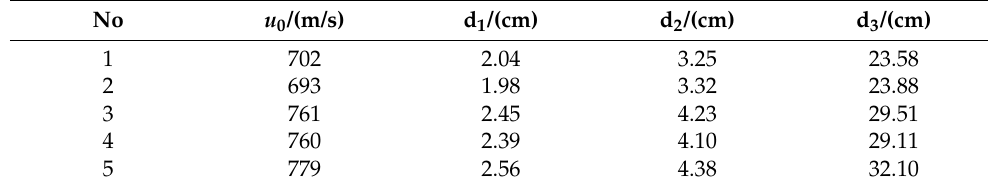
Table 6. Experimental results of 25-mm-thick target.